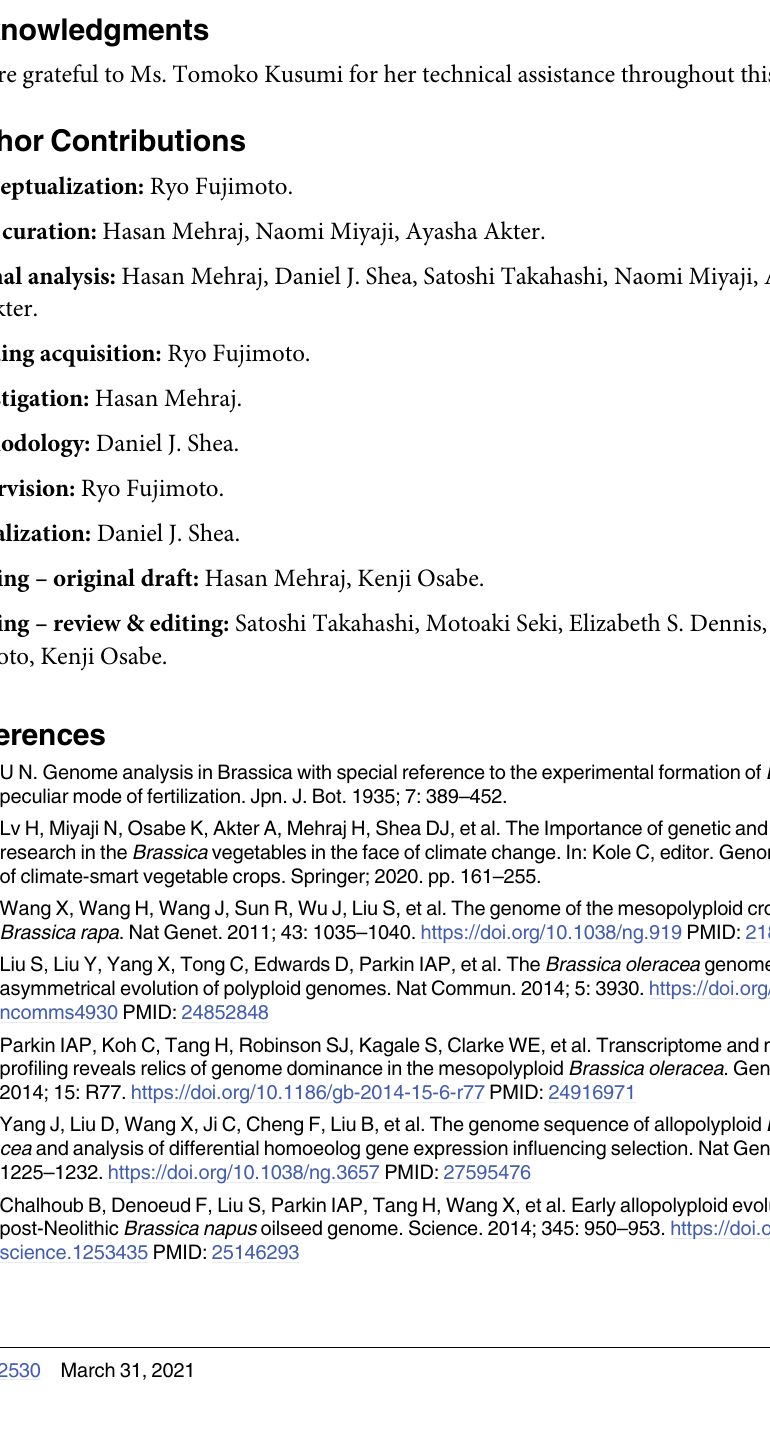
S6 Table. GO function term overrepresented in genes overlapping with NAT expressing loci and siRNAs (p < 0.0001). S7 Table. GO function term overrepresented in genes overlapping with NAT expressing loci and H3K27me3 (p < 0.0001). S8 Table. Sequences of the identified 12